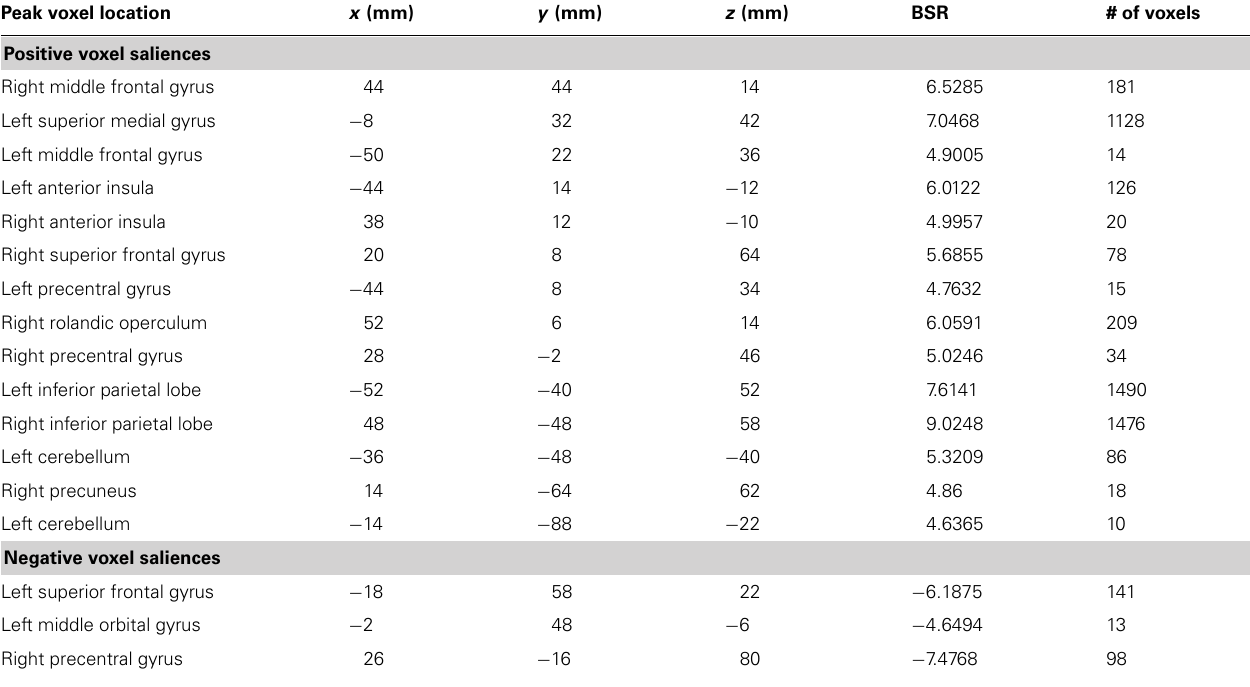
Table 1 | Dominant positive and negative voxel saliences identified by a single LV ( p < 0.001) in the task PLS differentiating path integration from optic flow